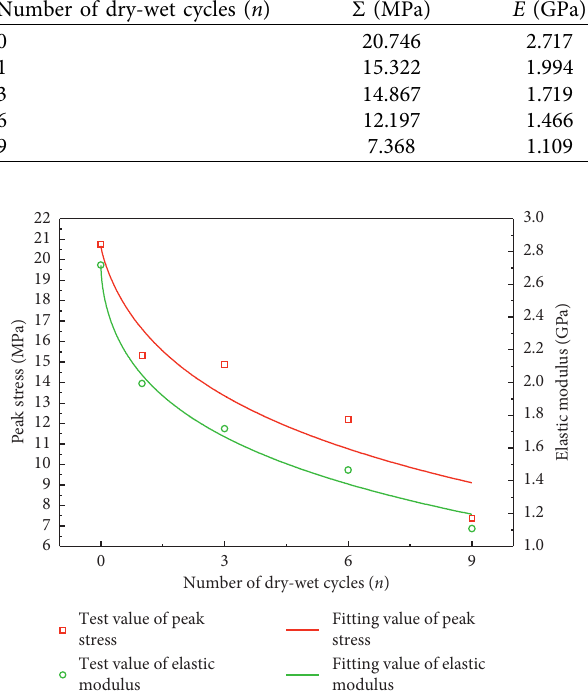
Figure 7: Curve of mechanical parameters of the samples with n .